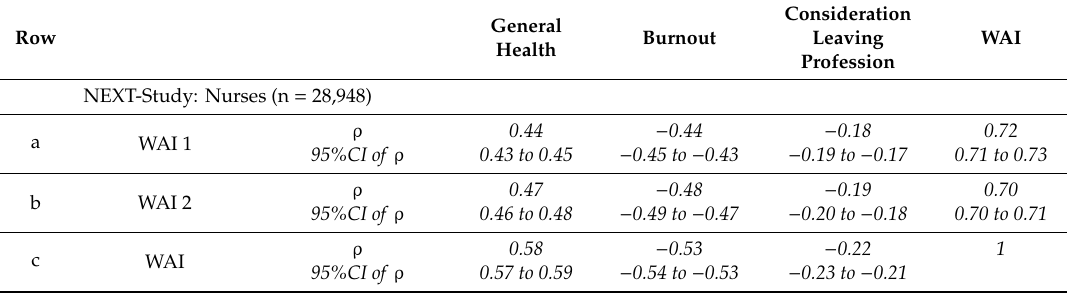
Table 1. Cross-sectional analyses—correlation (Spearman’s rho) of WAI 1, WAI 2 and WAI with the outcomes general health, burnout and consideration of leaving nursing. Investigation in three di ff erent cross-sectional samples (all t1). The 95% confidence intervals of rho were obtained by bootstrapping. All correlations were significant at p <